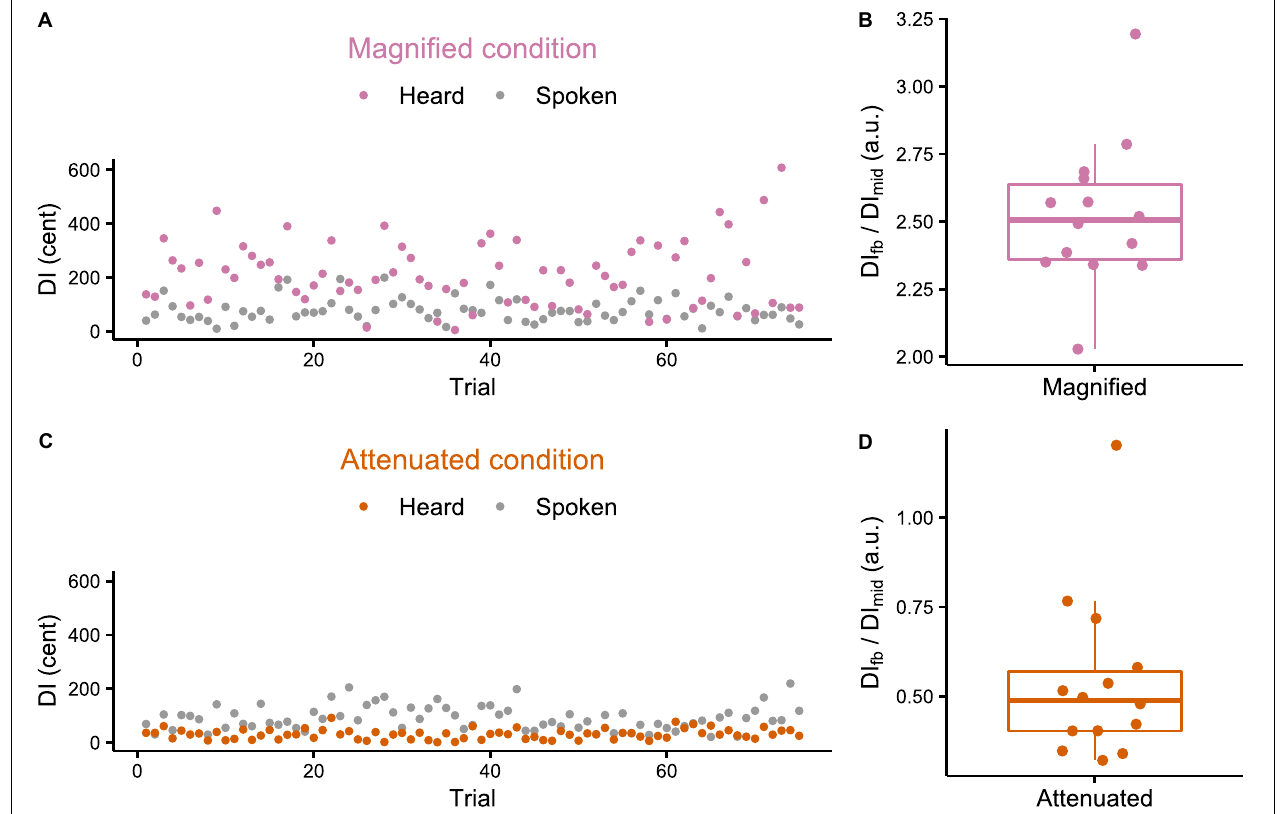
Frontiers in Human Neuroscience |